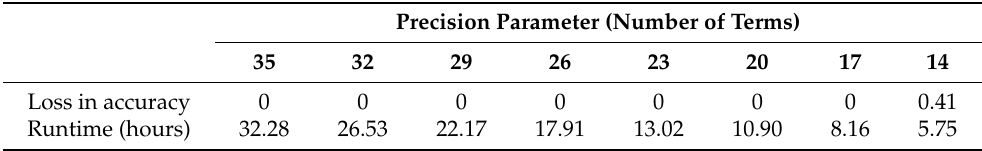
Table 7. Influence of the precision parameter on the loss of accuracy and on the computational time in the EEG-based predisposition to alcoholism detection use